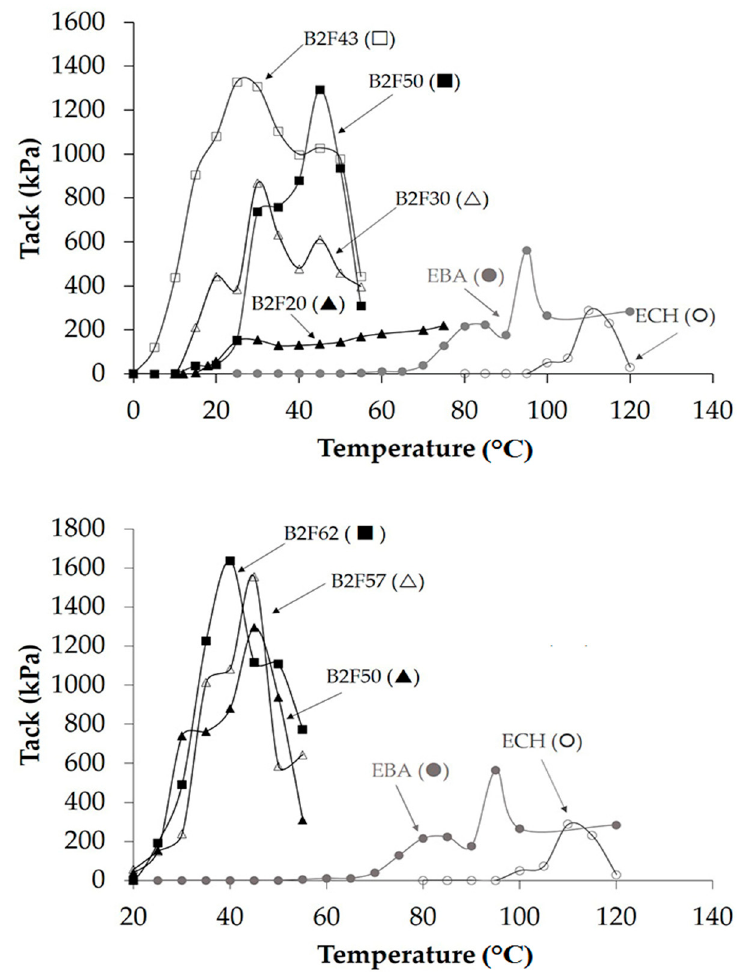
Figure 13. Variation of the tack of the EBA copolymer, ECH resin, and their binary blends as a function of the temperature.